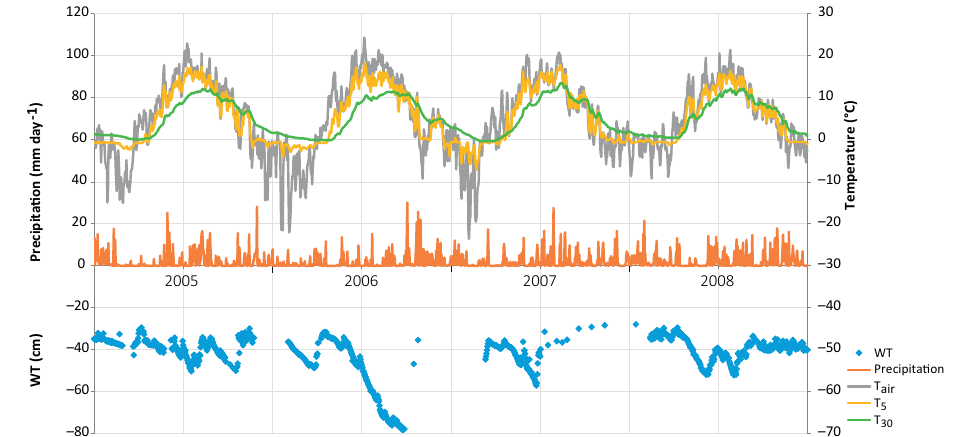
Figure 1. Daily weather data: precipitation (average from nearby weather stations), air ( T air ) and soil temperatures at 5cm ( T 5 ; d collars) and 30cm ( T 30 ) depths, and average water table (WT) level at Kalevansuo